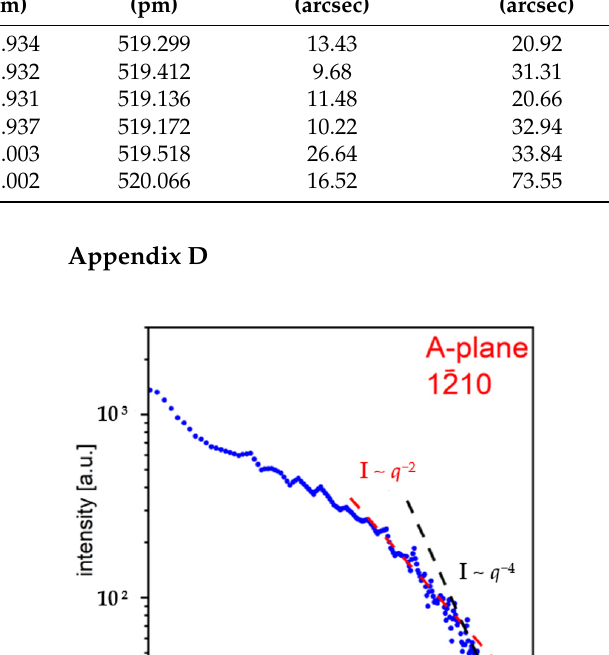
Table A2. Results of the HRXRD lattice parameters and ω -scan FWHM and FWTM measurements of the (cid:0) (cid:1) 1100 slice. Measurement positions: AP I—area (4)—center of the seed, AP II—area (4)—in the middle of the radius, AP III—area (1)—seed, AP IV—area (4)—close to the edge of the crystal, AP V—area (2) and AP VI—area (3).